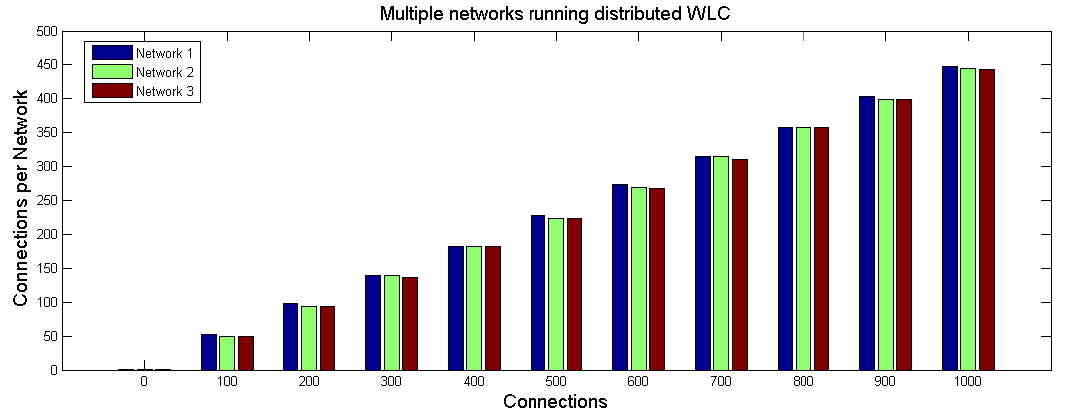
Figure 10. Multiple networks running distributed